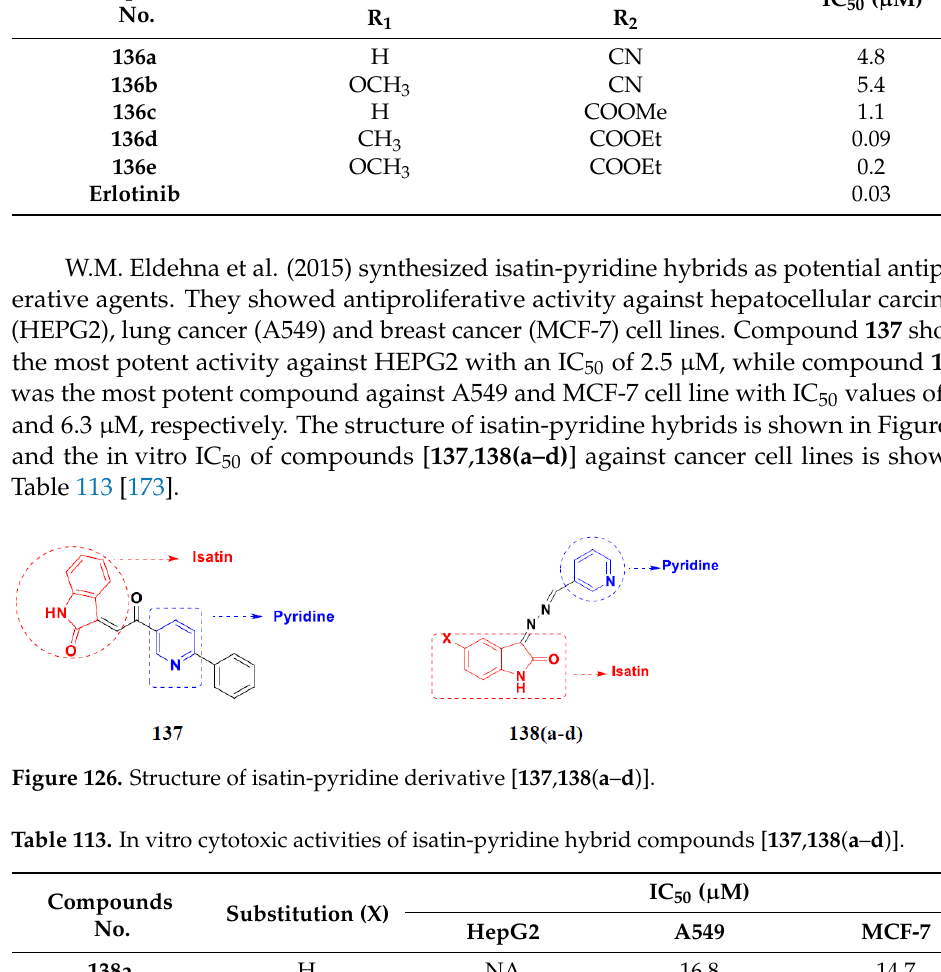
Figure 125. Structure of biquinoline-pyridine hybrid derivative 136 ( a – e ). Table 112. In vitro cytotoxic activities of biquinoline-pyridine hybrid compounds 136 ( a – e ). Compound